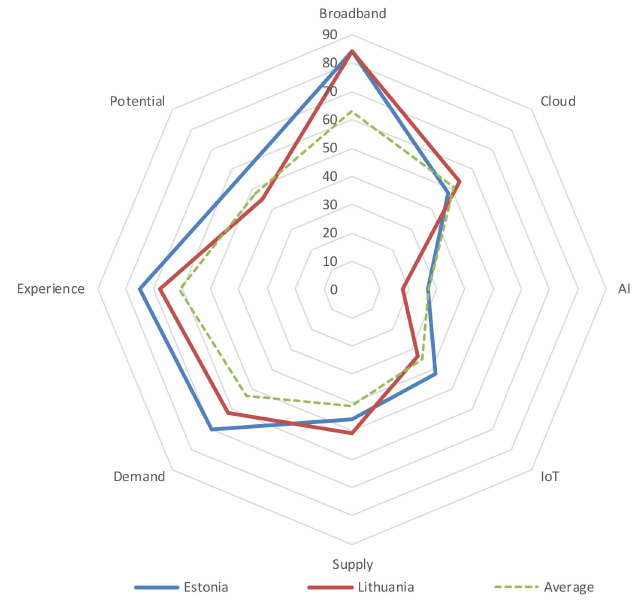
Figure 7. The level of digitization of Lithuania and Estonia based on GCI by types of technology (Broadband, Cloud, IoT, and AI) and digitization pillars (SDEP–Supply, Demand, Experience, and Potential) in 2019 compared to the average of the surveyed